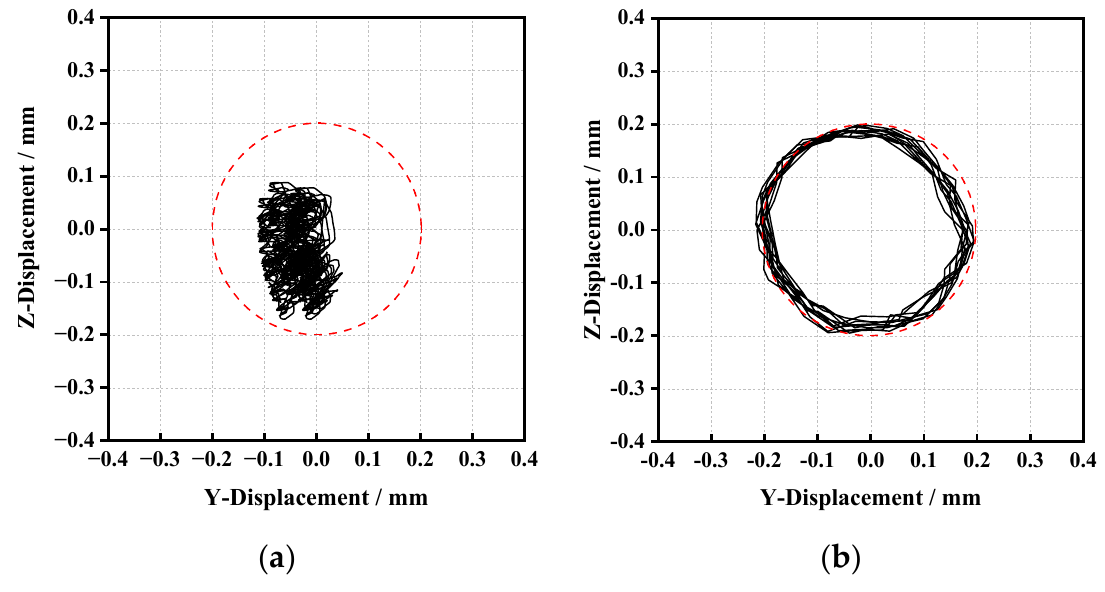
=200 N, = 10,000 r/min; ( b ) =200 N, 𝐹𝐹 𝑐𝑐 𝑛𝑛 𝑐𝑐 𝐹𝐹 𝑐𝑐